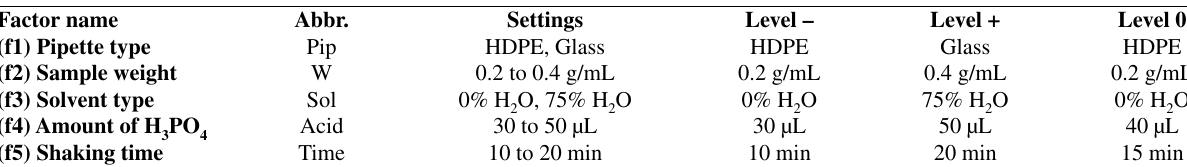
Table 5. Factors used in the experimental design for sample preparation optimization. Factor name